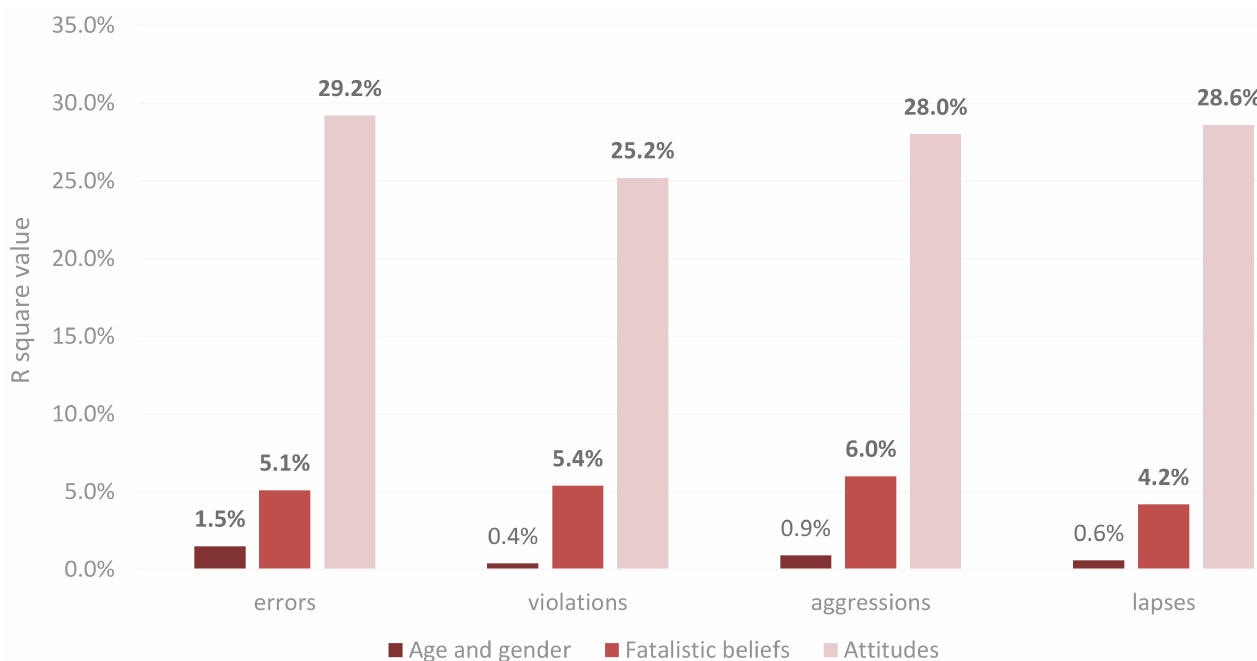
Figure 2. R 2 values for the prediction of PBQ scores (errors, violations, aggressions and lapses) considering the constructs of age and gender, fatalistic belief and attitudes. Bold numbers indicate statistically significant R 2 values ( p >